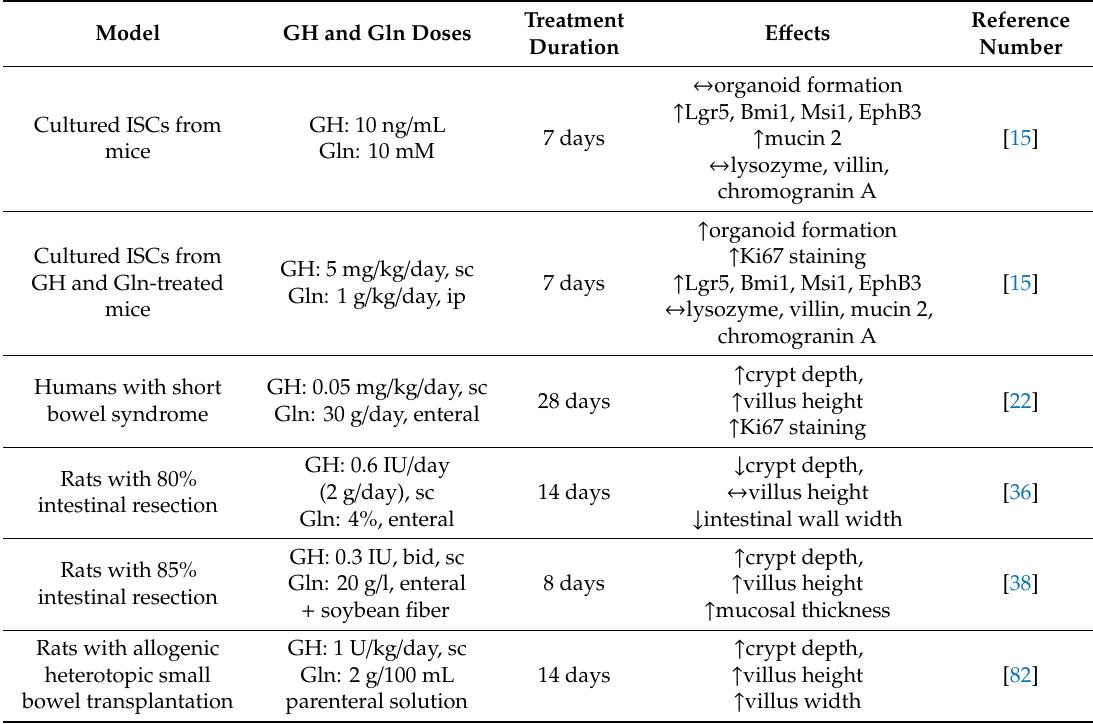
Table 3. E ff ects of growth hormone and glutamine combined treatment on intestinal crypt cells and stem